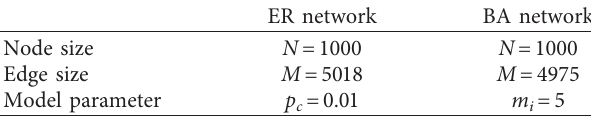
Table 2: Parameters of the generated network model.